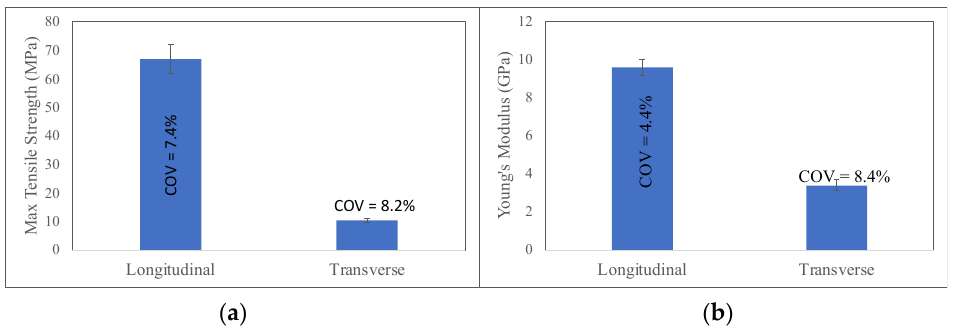
Figure 9. Longitudinal and transverse tensile properties of CRTM panels: ( a ) ultimate tensile strength, and ( b ) Young’s modulus.